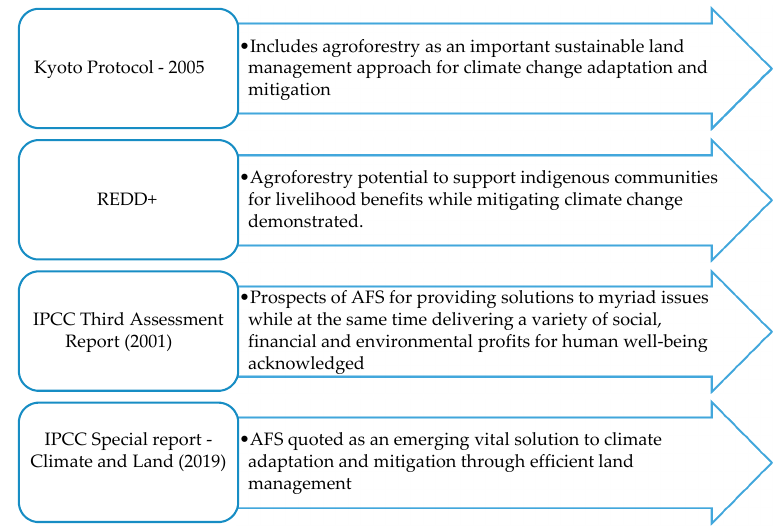
Figure 4. Agroforestry System in key agreements and reports (Source: [82–84]).